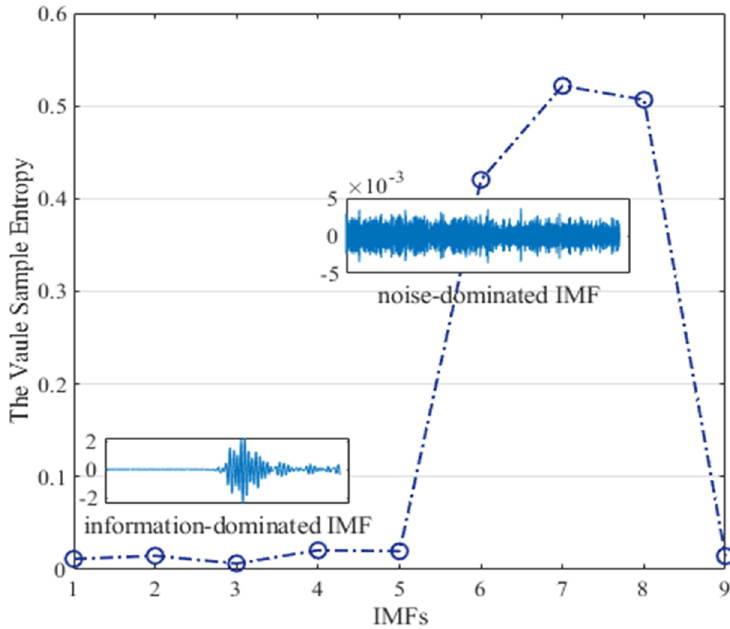
Figure 15. The classification of the IMFs.